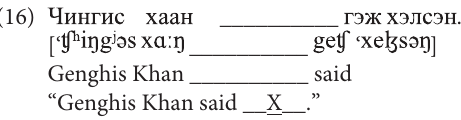
Rabbit Consonant Sink Circle From dad By the